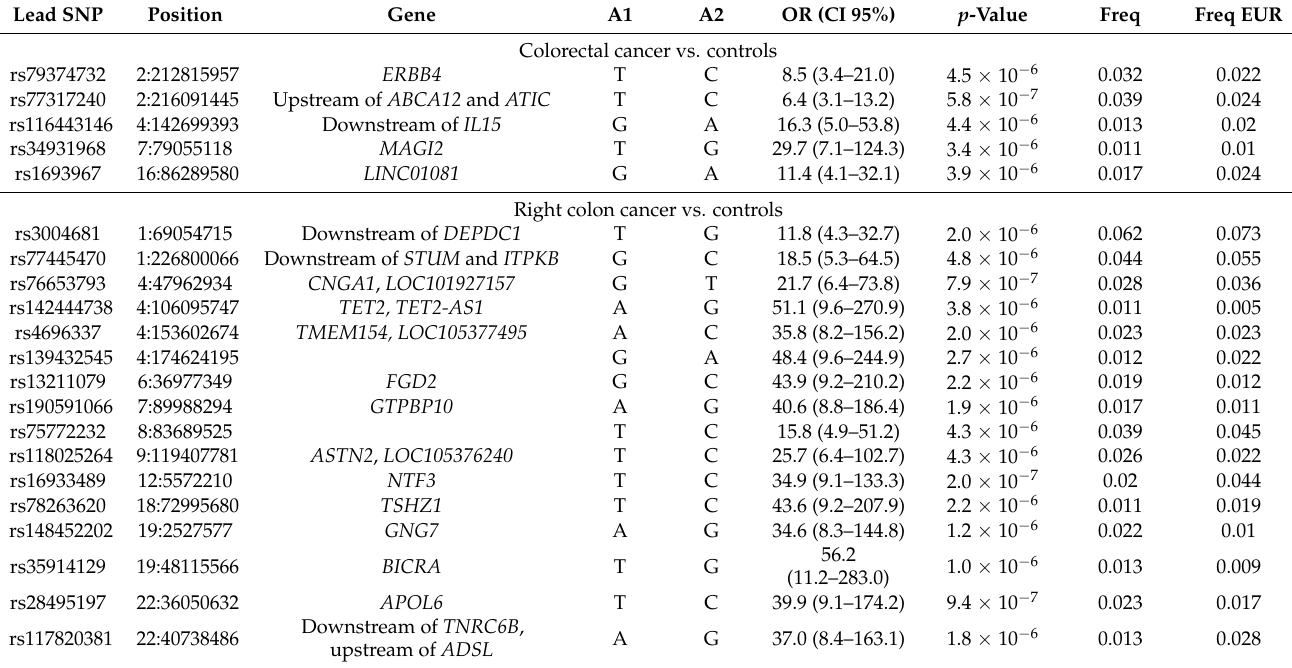
Table 2. Suggestive signals ( p < 5 × 10 − 6 ) detected in colorectal cancer and the locations. Gene, gene where is located the SNP or nearest gene 100kb upstream or downstream from the SNP. OR, odds ratio. CI 95%, confidence interval of 95% of the odds ratio. Freq, frequency of A1 in Basque cohort. Freq EUR, frequency of A1 in European populations of 1